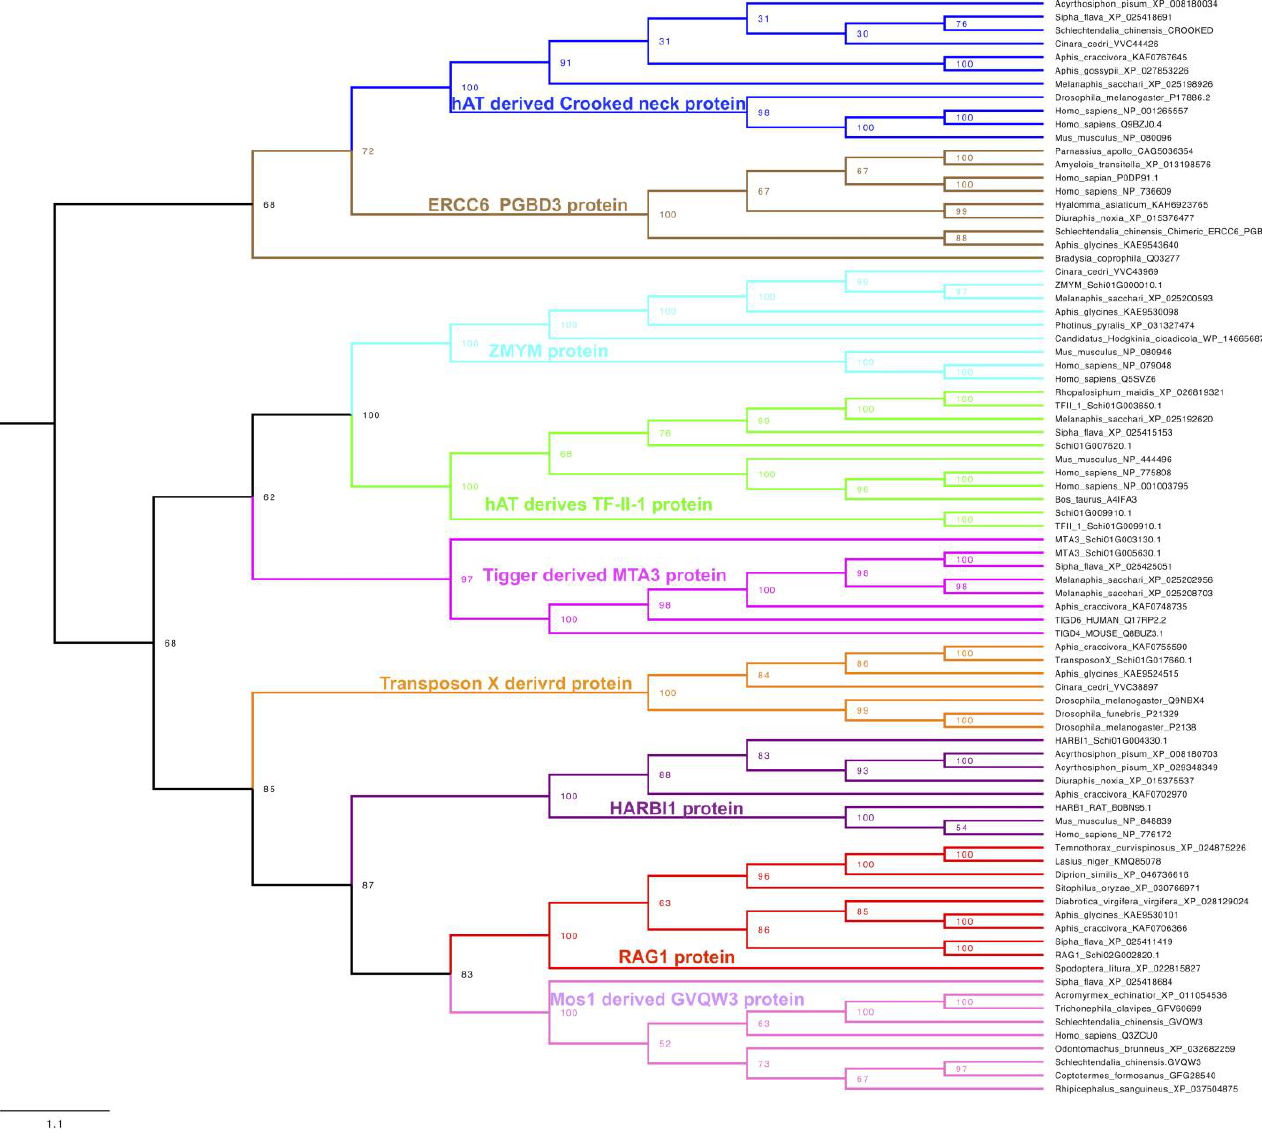
Figure 5. Phylogeny of the transposon-derived proteins retrieved from the genome of S. chinensis with other organisms retrieved from NCBI GenBank as a result of BlastP. Phylogenetic analysis of the sequences indicates their ancient domestications and can be found in insects to higher vertebrates. Clustering of the sequences derived from vertebrates, including humans with S. chinenis and other insects in the tree, represent their common origin. Each branch color in the tree represents a different group of transposon-derived proteins originating from the domestication of different TEs.